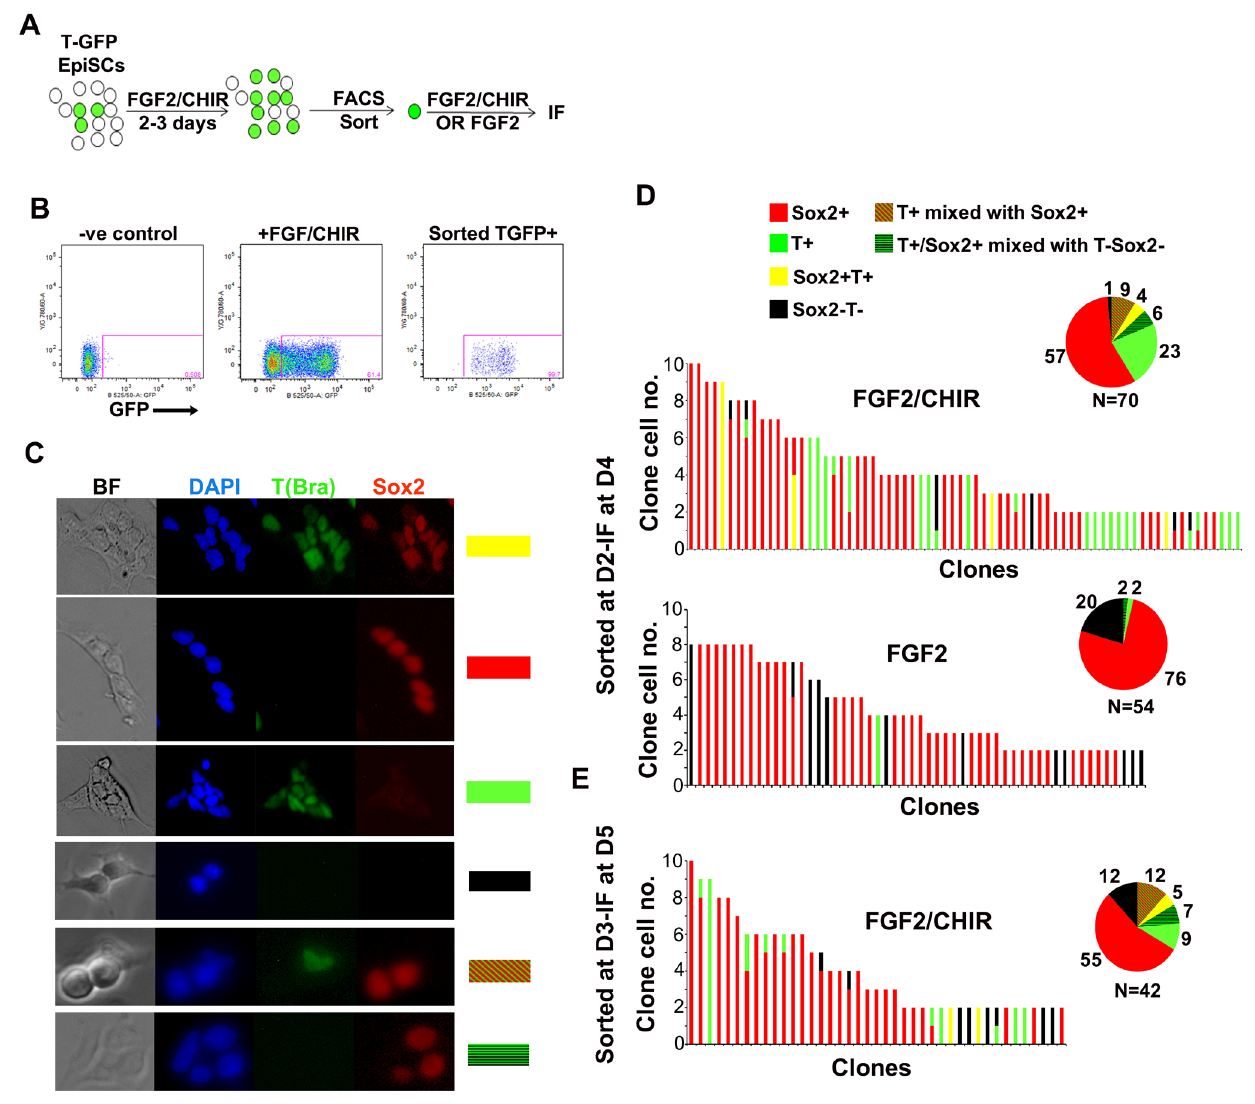
Figure 3. ( A ) Scheme depicting the differentiation and re-plating of in vitro induced NMPs at clonal density after flow sorting. ( B ) FACS plots depicting analysis of TGFP expression in day 3 FGF2/CHIR-treated TGFP EpiSCs (middle). The purity of the GFP + sorted population and a negative control (wild-type EpiSCs) are also shown. ( C ) Representative examples of the clones obtained after culture of single sorted TGFP + NMPs in FGF2/CHIR medium following immunofluorescence analysis of T(Bra) and Sox2 expression. The colour-coded bars on the right correspond to the scoring groups shown at the top of panel 3D. ( D – E ) Composition of colonies obtained after clonal plating of TGFP + NMPs sorted at day 2 ( D ) or day 3 ( E ) for a further 48 hrs in FGF2/CHIR or FGF2 only. The cell number of each clone (in x axis) is shown in the y axis. Colour codes: Sox2+: single Sox2+ cells; T+: single T+ cells; Sox2+T+: Double positive cells; Sox2-T-cells: double negative cells; T+ mixed with Sox2+: clones consisting of single T(Bra)+ cells mixed with single Sox2+ cells; T+/Sox2+ mixed with T-Sox2-: clones consisting of single T(Bra)+ or single Sox2+ cells mixed with double negative cells. Pie charts: percentages of different classes of clones representing groups of the colour-coded phenotypes described above. Total numbers of clones scored are shown below each pie